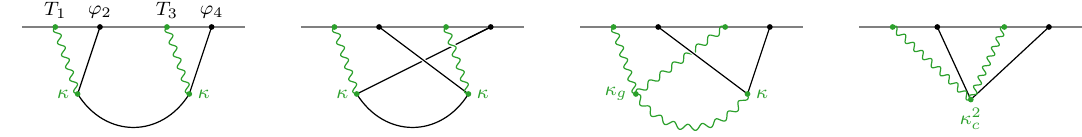
Figure 9: Diagrammatic representation of different contributions to the gravitational Compton